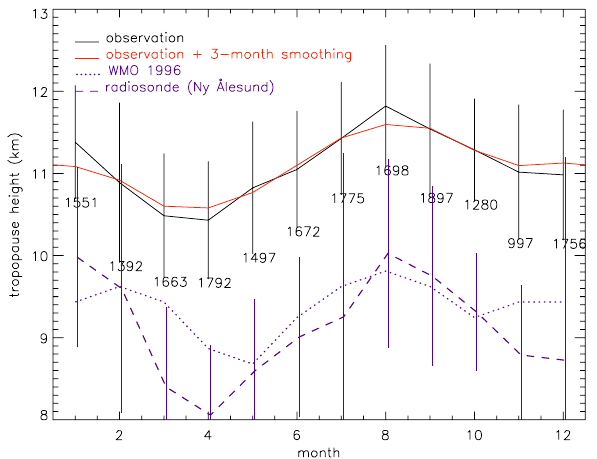
Fig. 2. Monthly values of tropopause height. The upper black line shows the monthly climatology for the period 2008–2010 inclusive as determined by radar, the vertical bars indicating the standard de- viation and the numbers showing the number of hourly values used for each point. The overlying smooth line shows a 3-month Lee filter smoothing to illustrate the mid-winter weak secondary maxi- mum. The WMO 1996 model is indicated by the dotted line, while the dashed line shows the corresponding values obtained from ra- diosonde measurements at Ny ˚Alesund, 120km to the NW of the radar (standard deviation bars are very slightly offset for clarity).